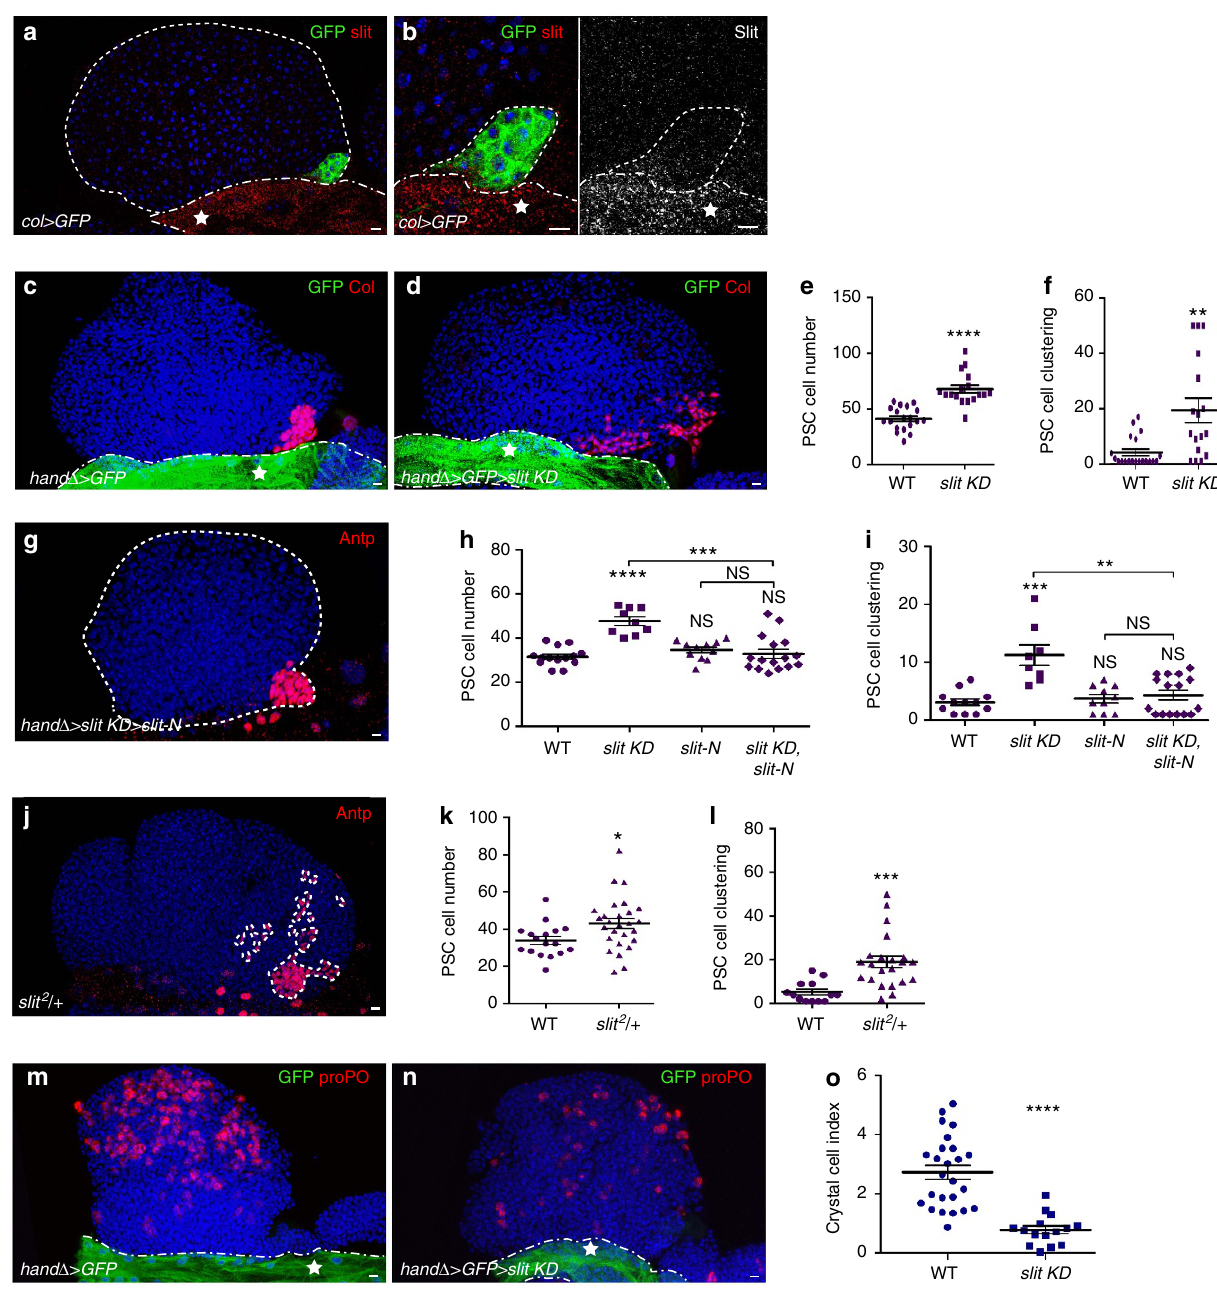
Figure 3 | Slit expressed in the cardiac tube is required to control PSC morphology. ( a , b ) PSC cells express GFP ( col 4 GFP , green) under the PSC col driver. Slit (red in a and b and white in smaller right b ) is expressed at high levels in the cardiac tube indicated by a star. ( b ) Enlarged views showing weak Slit expression in PSC cells (red and white left and right panels, respectively). ( c , d ) PSC cells are labelled by Col (red) and the cardiac tube expresses GFP under the control of the cardiac tube driver hand D ( hand D4 GFP , green). Compared with control ( c ), reducing Slit levels in the cardiac tube leads to an increased number of PSC cells and the loss of their clustering ( d ). ( e , f ) Quantification of PSC cell numbers and PSC cell clustering, respectively. ( g ) Antp (red) labels PSC in hand D4 slit KD 4 Slit-N. The slit KD PSC defect is rescued by Slit-N overexpression in the CT. ( h , i ) Quantification of PSC cell numbers ( h ) and PSC cell clustering ( i ); * corresponds to the comparison with WT, whereas * above a bar indicates the two conditions being compared. ( j ) Antp (red) labels the PSC in slit 2 / þ heterozygote mutant. ( k , l ) Quantification of PSC cell numbers ( k ) and PSC cell clustering ( l ). ( m , n ) Crystal cells are labelled by prophenoloxidase (proPO) antibody (red) and the cardiac tube expresses GFP ( hand D4 GFP , green) under the control of the cardiac tube driver Hand D . Fewer crystal cells differentiate in LGs, when slit expression is decreased in the cardiac tube ( n ), compared with WT ( m ). ( o ) Crystal cell index in m and n contexts. Statistical analysis t -test (Mann–Whitney nonparametric test) was performed using GraphPad Prism 5 software. Scale bars, 10 m m. the Wnt/Wg pathway 44 , and the transgene dfz3-red fluorescent (Supplementary Fig. 6). Furthermore, to determine whether protein is a reporter of the Wnt/Wg pathway activity in the PSC. BMP/Dpp signalling was affected, we analysed the expression of Reduction of robo function in the PSC did not affect dfz3-RFP dad-GFP, a reporter of the pathway 20 . Reduction of robo function expression, indicating that Wnt/Wg signalling was not impaired in the PSC led to a decrease in dad-GFP expression. This effect, NATURE COMMUNICATIONS|7:11634|DOI: